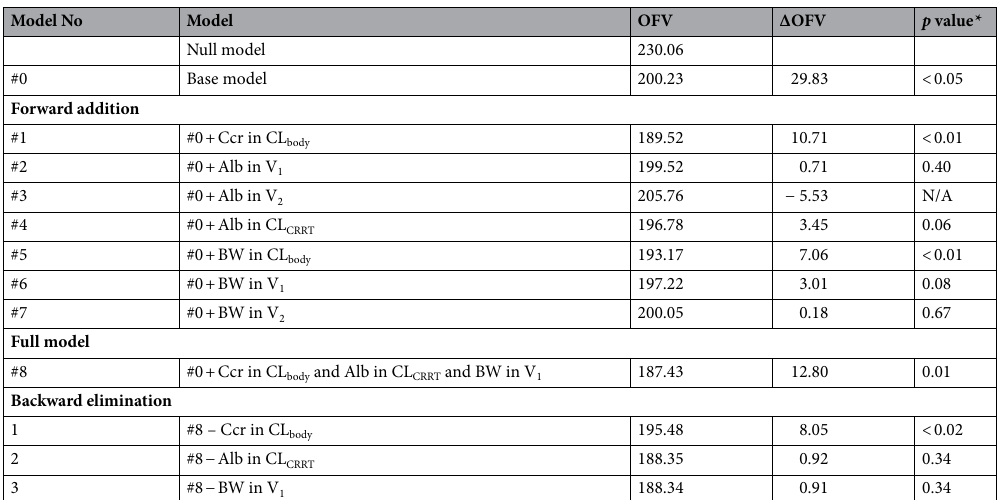
Table 2. Forward addition step and backward elimination step. OFV objective function value, ΔOFV distribution of OFV between models, Null model normal 2-compartment model, Base model 2-compartment model considering clearance by continuous renal replacement therapy, CL body clearance from body, CL CRRT clearance by continuous renal replacement therapy, V 1 distribution volume of central compartment, V 2 distribution volume of peripheral compartment, Ccr creatinine clearance, Alb serum albumin, BW body weight. *For one degree of freedom, ΔOFV below 2.71 or 3.84 was regarded as significant ( p < 0.10 in forward addition, p < 0.05 in backward